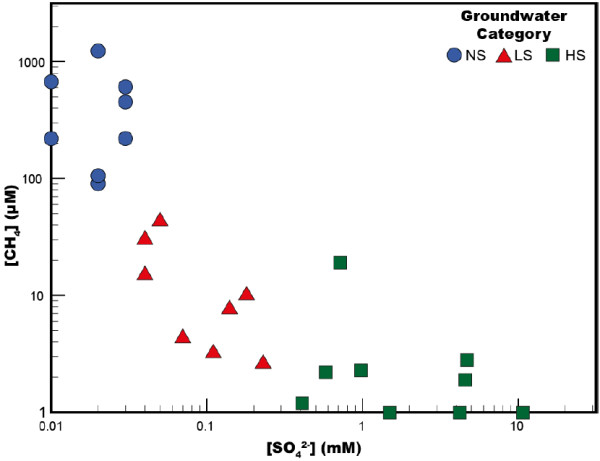
A comparison of the methane (CH4) and sulfate (SO42-) concentrations of individual wells in the Mahomet aquifer. The amount of sulfate in HS wells is > 0.2 mM, is between 0.03 and 0.2 mM in LS wells, and is less than 0.03 mM in NS wells.